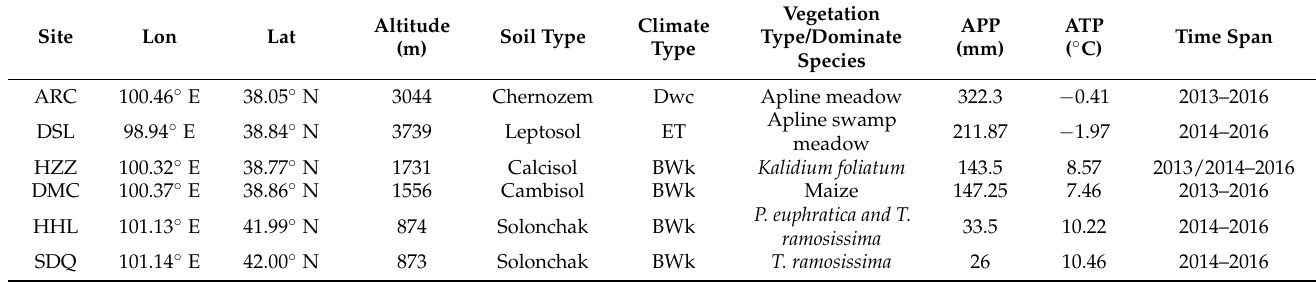
Table 1. Main characteristics of the typical ecosystems in the study